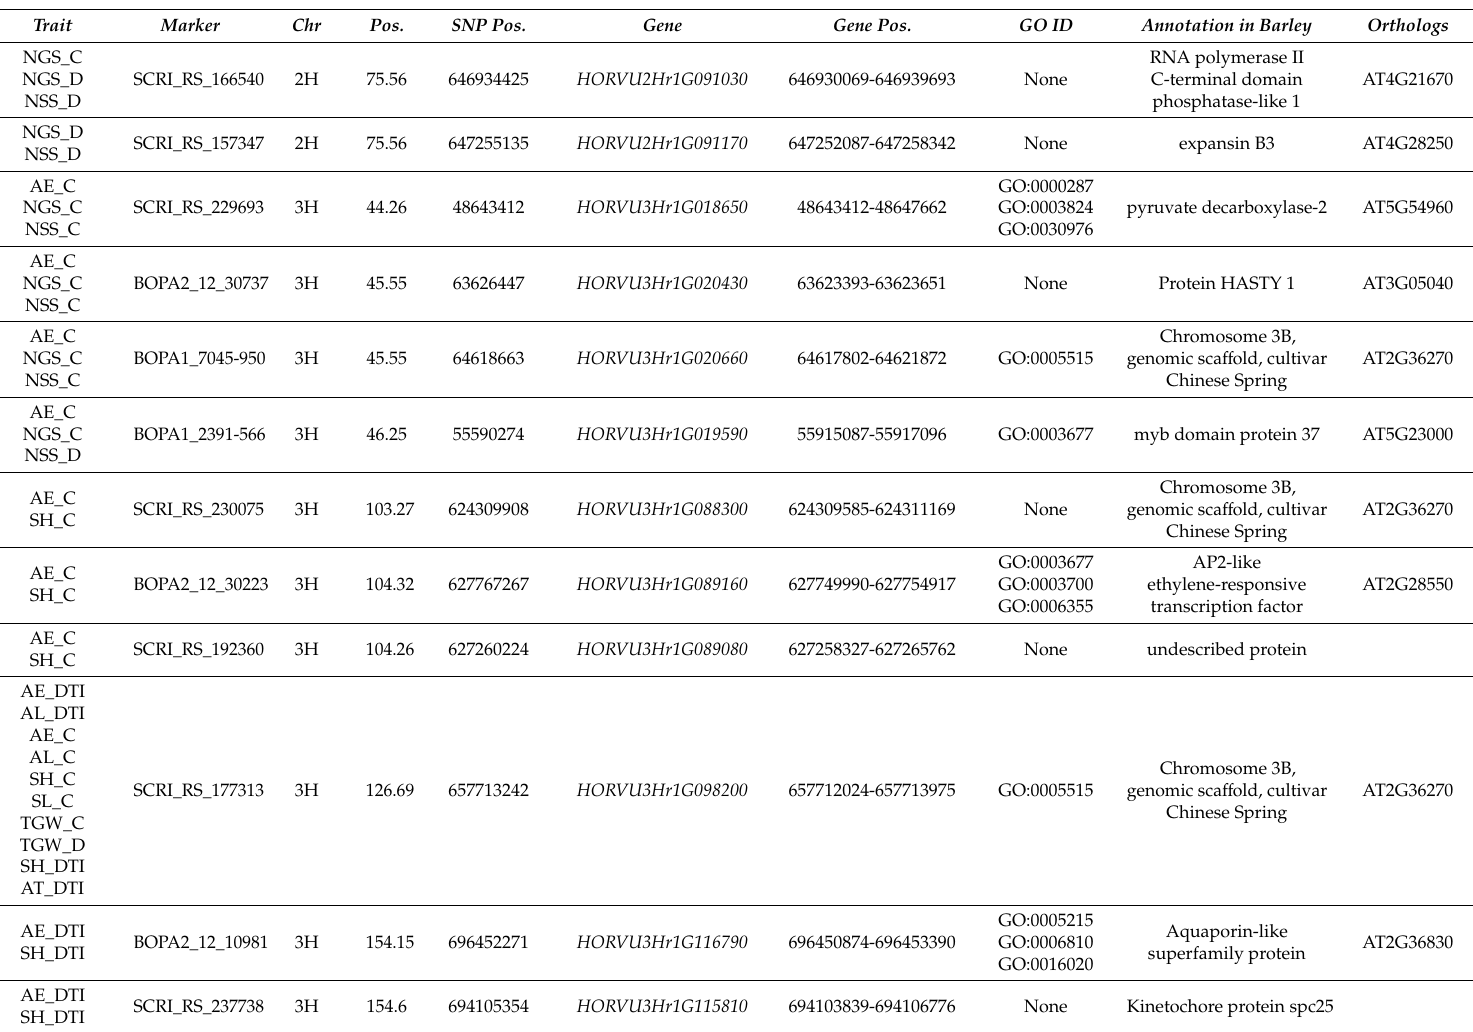
Table 3. The functional annotation of the putative candidate genes associated with the studied traits under drought and control growth conditions.